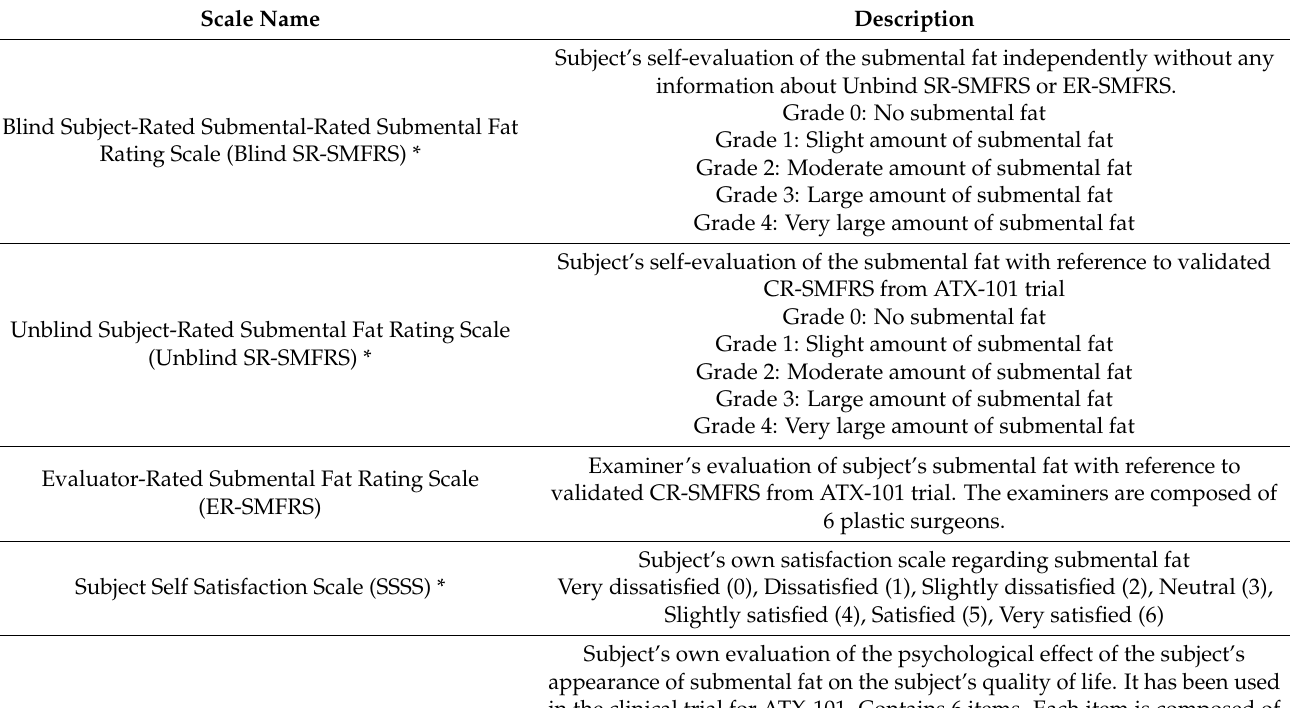
Table 2. Scale used in the